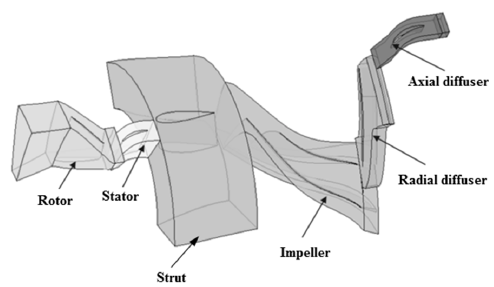
Figure 4. Computational fluid dynamics (CFD) computational domain of the compressor.